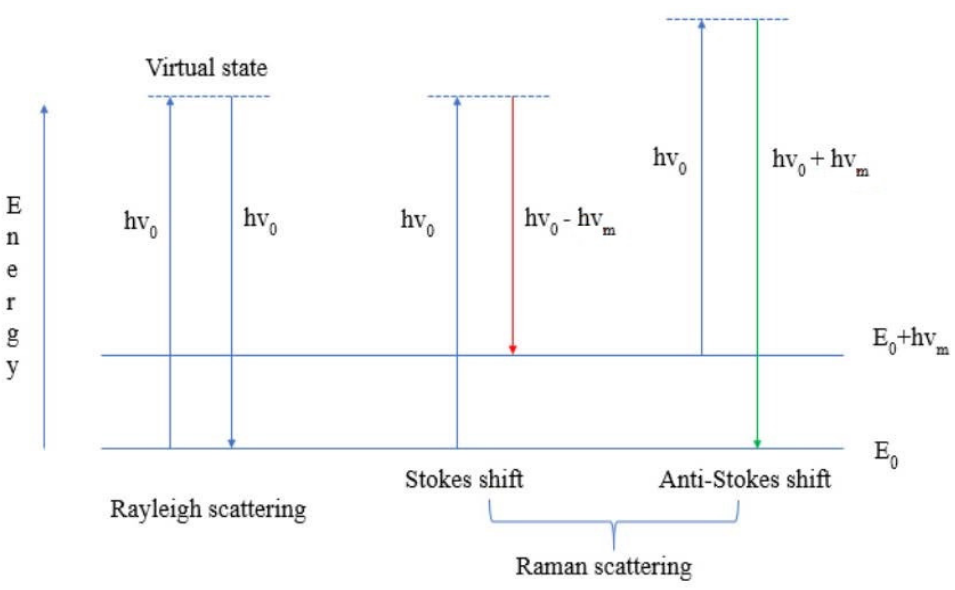
Figure 2. Energy transition of Rayleigh and Raman scattering.